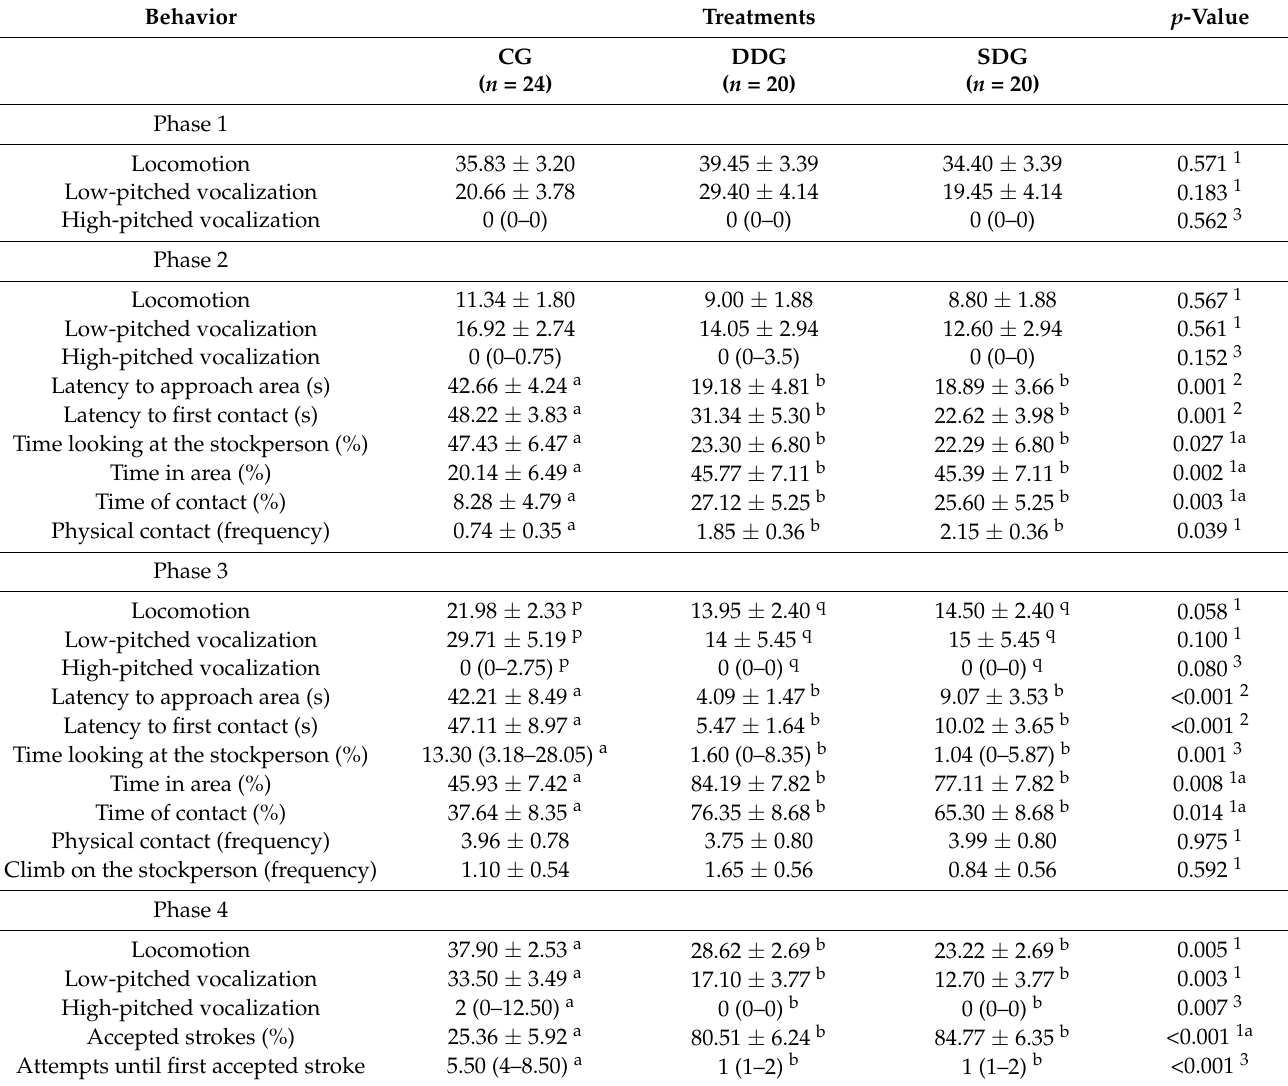
Table 3. Pigs behavioral responses during the different phases of the open-field arena test according to their treatment.